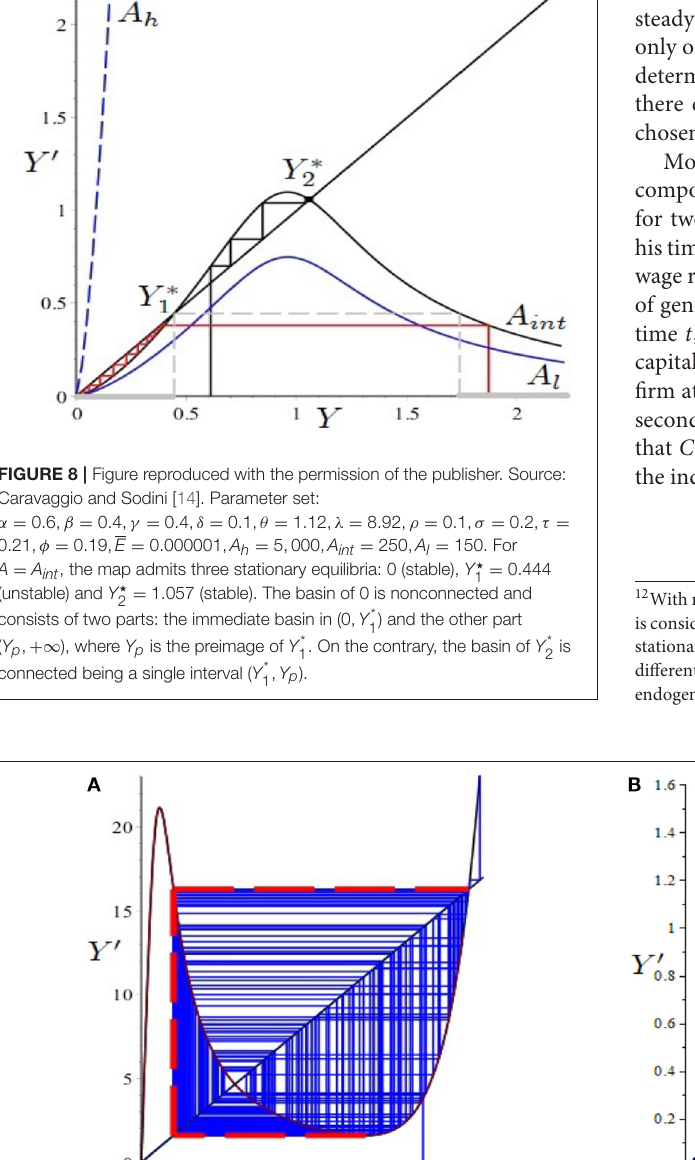
Frontiers in Applied Mathematics and Statistics |